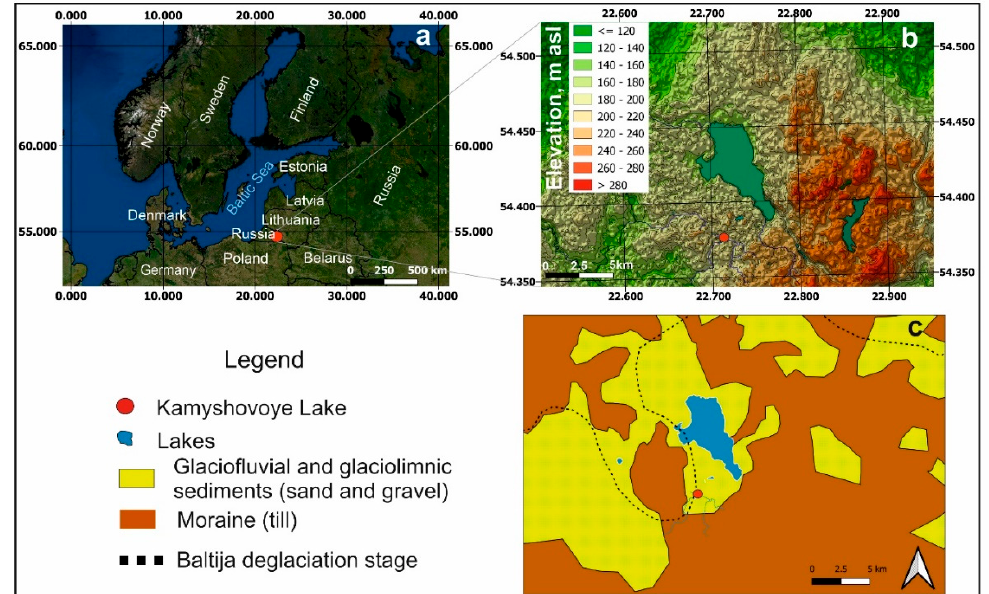
Figure 1. ( a ) Location of the Kamyshovoye Lake in the Baltic region, ( b ) relief, ( c ) quaternary geology of the surrounding area.